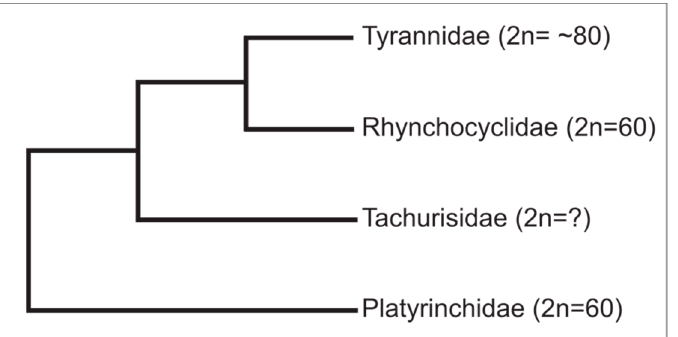
Figure 4. Chromosomal data plotted on a phylogenetic tree adapted from Harvey et al. [6]. The diploid numbers (2n) for Rhynchocyclidae and Platyrinchidae are based in the data obtained to Tolmomyias sulphurescens (present study) and Platyrinchus mystaceus [13]. The 2n for Tyrannidae is considered as ~80 because most of the species karyotyped so far in this family have approximately 80 chromosomes (Table 1).